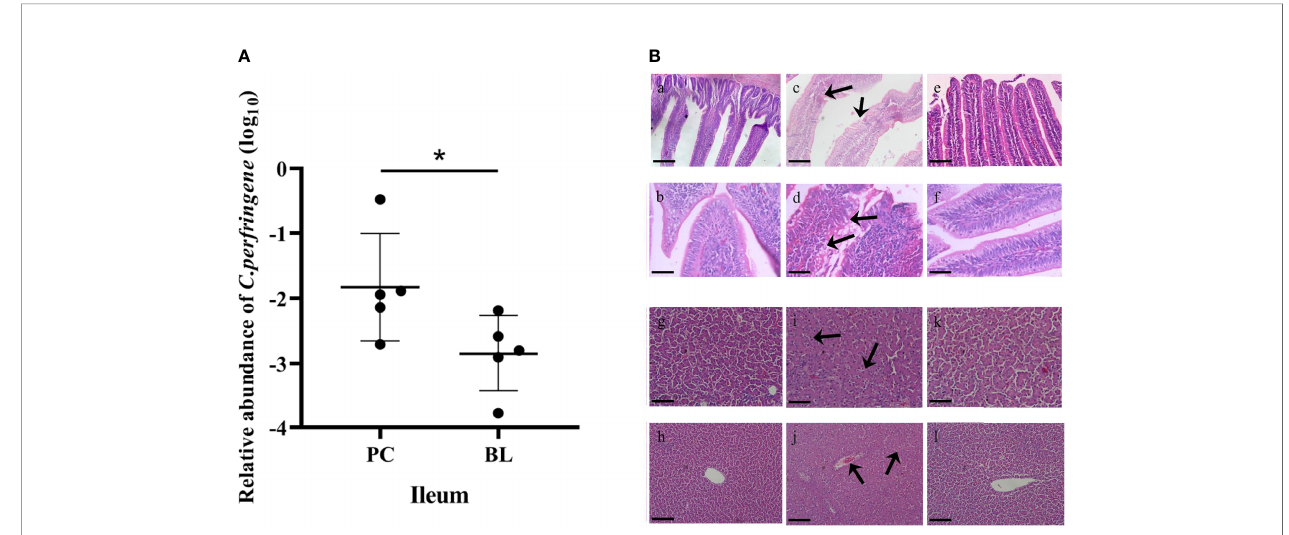
FIGURE 2 | Probiotic H2 suppresses proliferation of CP and SNE-induced in fl ammation in broiler chickens. (A) Relative abundance of C. perfringens in the ileum. *P <0.05, n = 6, measured using ANOVA. (B) Hematoxylin – eosin (H&E) staining in the ileum and liver. Scale bar: 2 mm. (A – F) Images of ileal sections. (A) NC group (magni fi cation ×200); ( B ) NC group (magni fi cation ×400); (C) PC group (magni fi cation ×200); (D) PC group (magni fi cation ×400); (E) BL group (magni fi cation ×200); (F) BL group (magni fi cation ×400). (G – L) Images of liver sections. (G) NC group (magni fi cation ×200); (H) NC group (magni fi cation ×400); (I) PC group (magni fi cation ×200); (J) PC group (magni fi cation ×400); (K) BL group (magni fi cation ×200); (L) BL group (magni fi cation